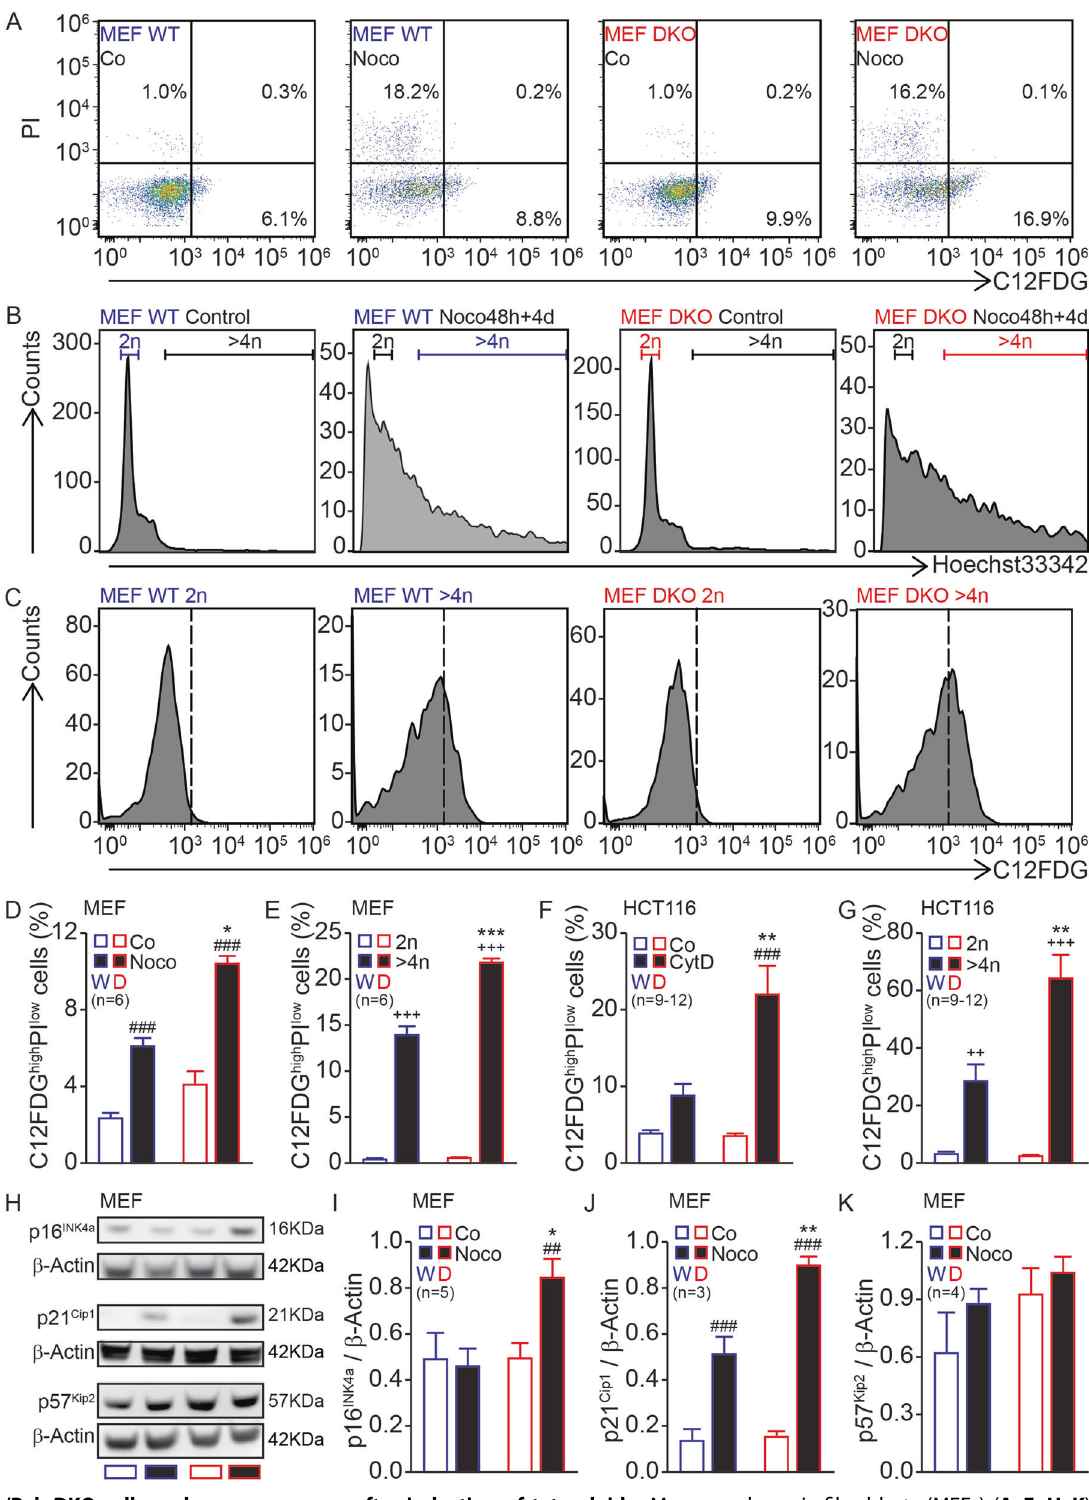
Fig. 3 Bax/Bak DKO cells undergo senescence after induction of tetraploidy. Mouse embryonic fi broblasts (MEFs) ( A – E , H – K ) or human colon carcinoma HCT116 cells ( F , G ) were seeded, treated or not with 100 nM Nocodazole (Noco) or 1.2 μ M cytochalasin D (CytD) for 48 h, then washed and kept in a drug-free medium for 4 days. Then, cells were stained with the vital dye propidium iodide (PI), the β -galactosidase substrate, C 12 FDG, and the fl uorescent stain for DNA, Hoechst 33342. Live cells ( A ) were subjected to DNA content analysis ( B ). C12FDG was analyzed both in the total population ( D , F ) and according to ploidy (2 n or >4 n ) ( C , E , G ). Alternatively, p16 INK4a ( H , I ), p21 Cip1 ( H , J ), and p57 Kip2 ( H , K ) in MEFs were determined by immunoblotting. Bars with blue contours represent WT ( “ W ” ) cells and bars with red contours represent Bax/Bak DKO ( “ D ” ) cells. White columns represent control or 2 n cells and black columns represent treated or >4 n cells. Error bars indicate SEM. Data were compared by R software using standard linear model inference, “ lm ” function. ## p < 0.01, ### p < 0.001 treatment vs. control. ++ p < 0.01, +++ p < 0.001 > 4 n vs. 2 n . * p < 0.05, ** p < 0.01, ** p < 0.001 for treatment effect, DKO vs.